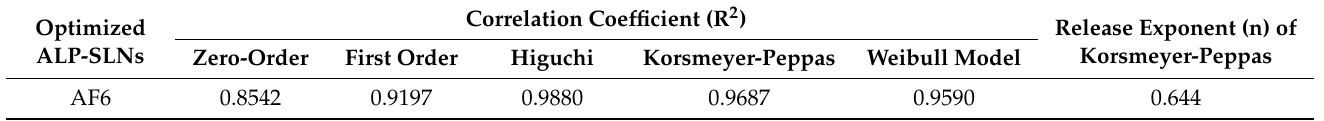
Table 4. Release kinetic models for